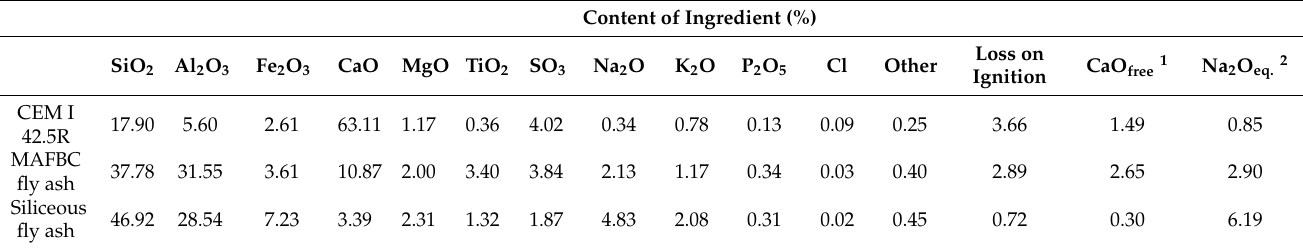
Table 2. Chemical composition and physical properties of cement and mineral additives. Content of Ingredient (%)